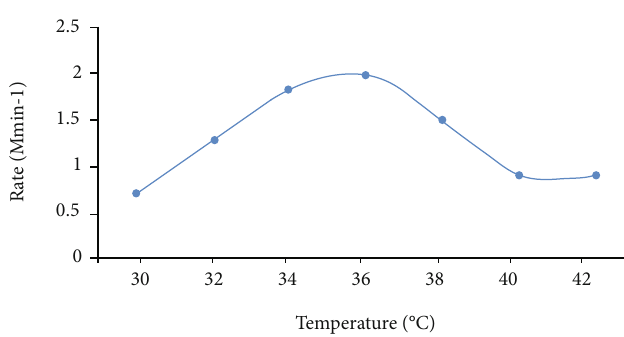
Figure 4: Variation of rate of fermentation with temperature of substrate using 50 ( v / v %) substrate, yeast 1.0 ( w / v %), and pH 5.0 [69].